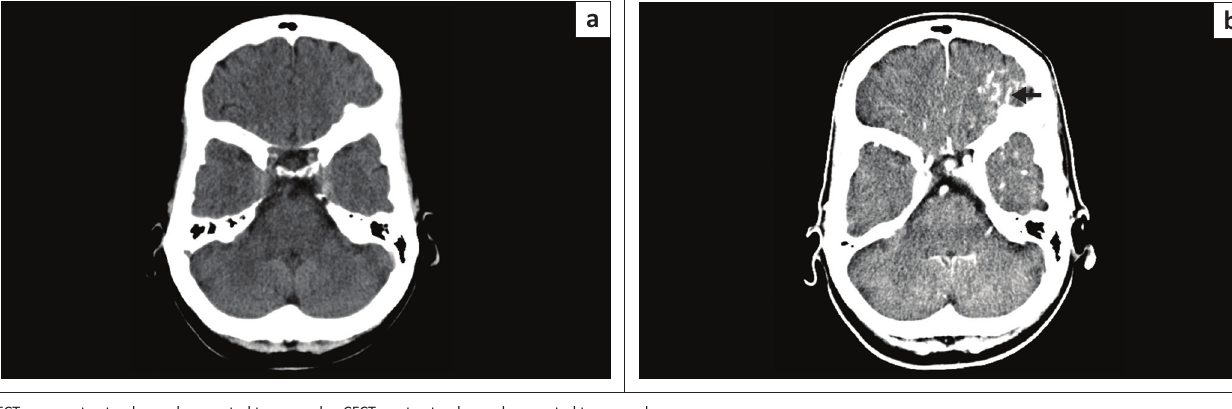
NECT, non-contrast-enhanced computed tomography; CECT, contrast-enhanced computed tomography. FIGURE 4: (a) NECT and (b) CECT of the brain. No abnormal finding is visible on the NECT but the CECT reveals a vascular abnormality left frontally